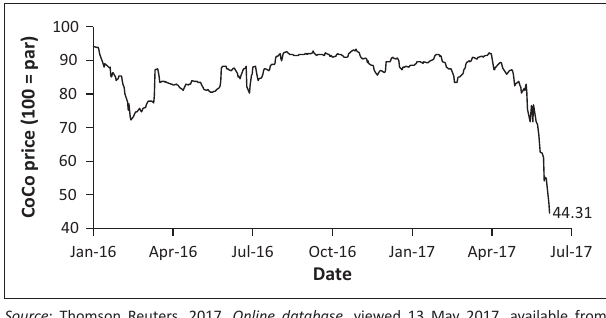
FIGURE 2: Banco Santander 8.25 % contingent convertible price (US